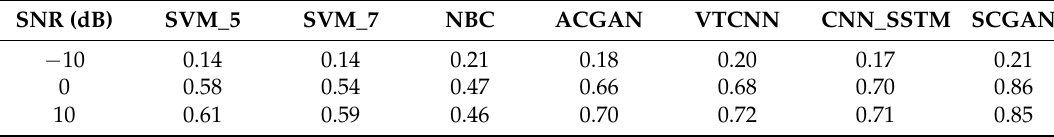
Figure 8. Overall classification accuracy versus SNR. Table 5. Overall classification accuracy versus typical SNR.